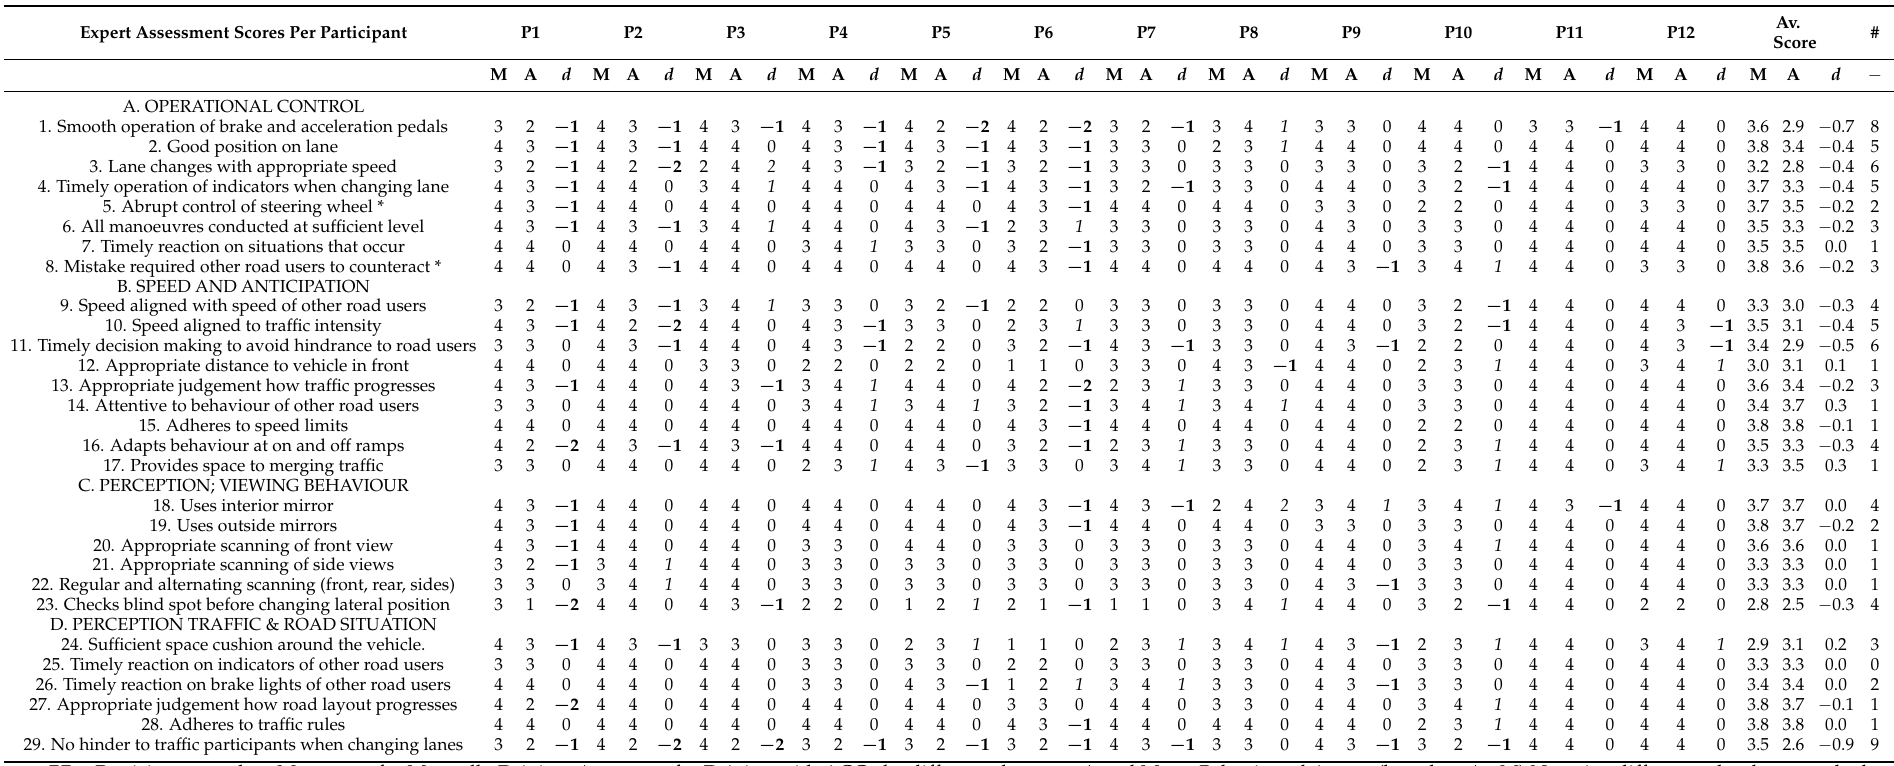
Table A2. Expert Assessment Scores of Behavioural Aspects for Manually Driving vs. Driving with ACC based on